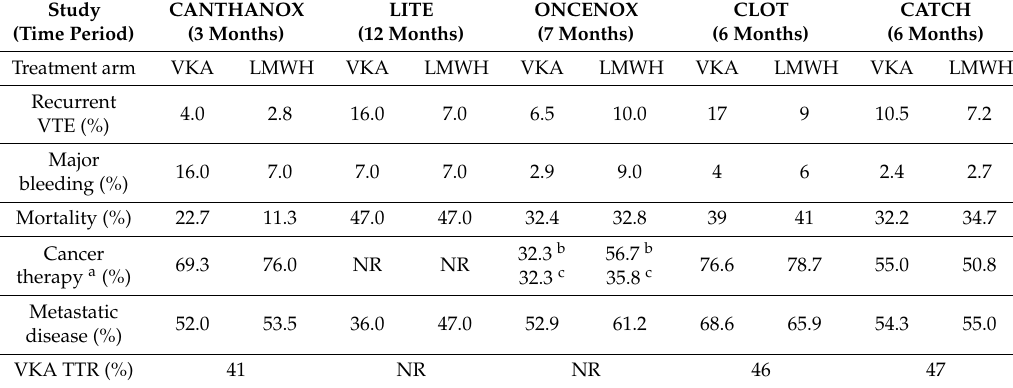
Table 1. Summary of randomized trials comparing VKAs with LMWH